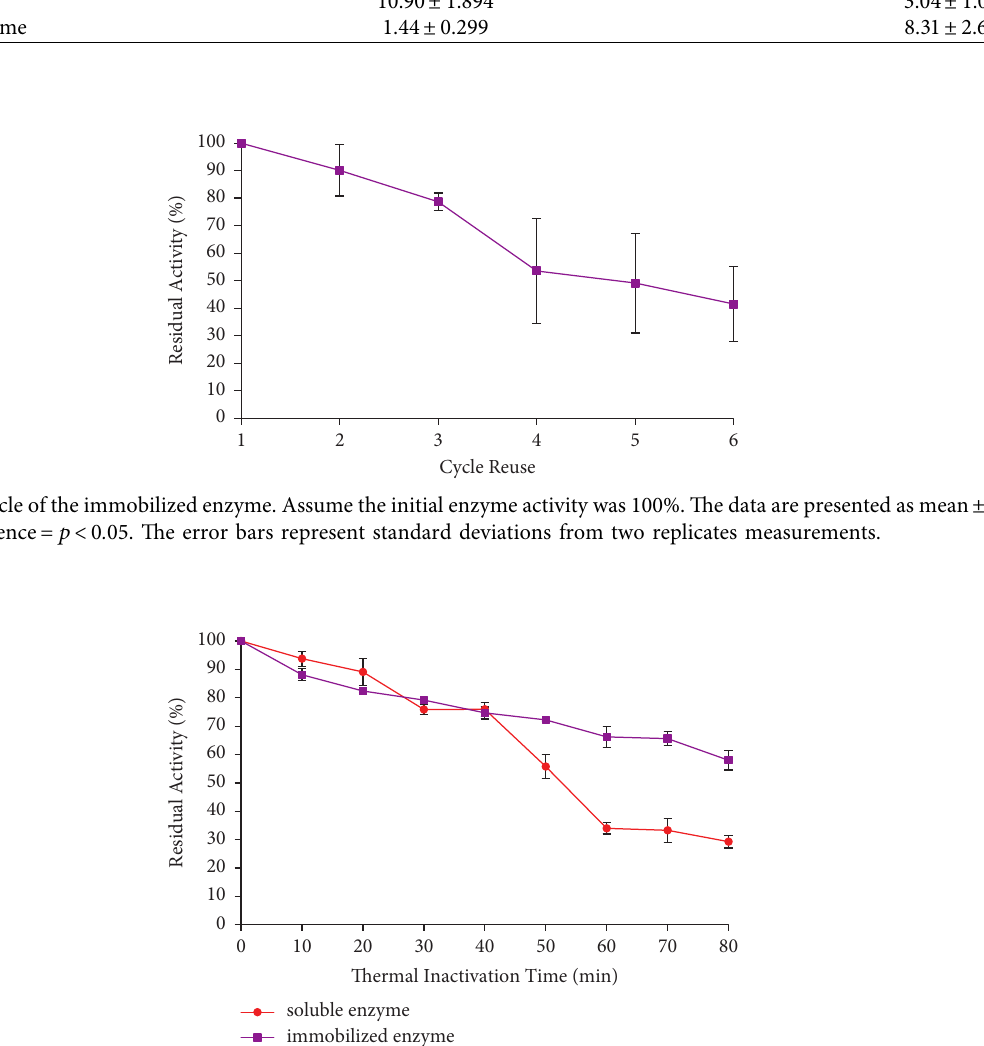
Figure 6: Thermal stability of the soluble and immobilized enzymes. The data were determined at each optimum temperature and each optimum starch concentration. Assume the initial enzyme activity was 100%. The data are presented as mean ± SD; n � 2; a significant difference � p < 0 . 05. The error bars represent standard deviations from two replicates